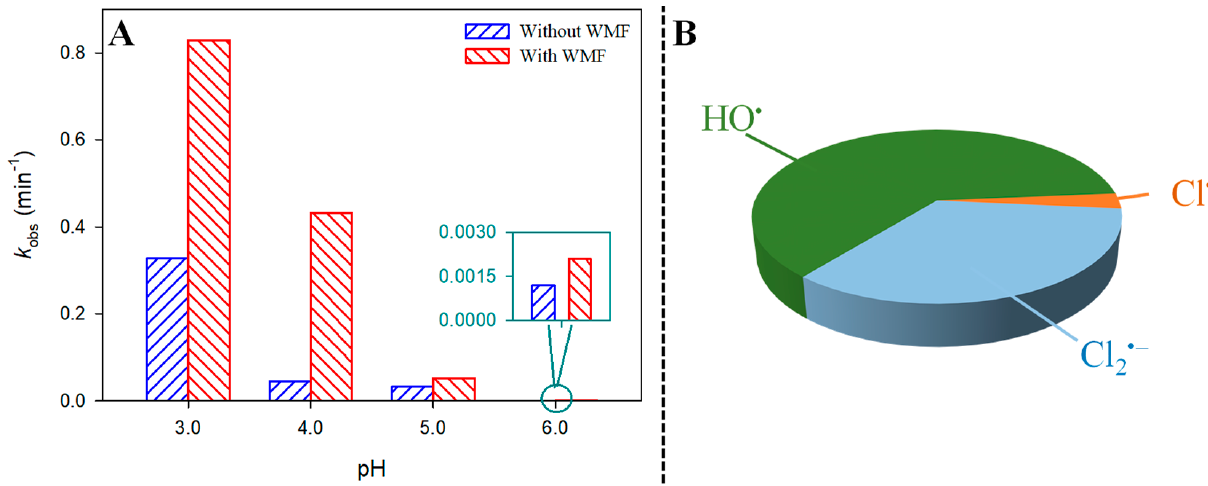
Figure 1. ( A ) Influence of WMF on the pseudo-first-order rate constants of BPA degradation by Fe 0 /H 2 O 2 process at different pH. ( B ) Contribution of different radicals for BPA removal at pH 5.0. Reaction conditions: [BPA] 0 = 0.2 mM, [Fe 0 ] 0 = 7 mM, [H 2 O 2 ] 0 = 6 mM, [Cl − ] = 2 mM.